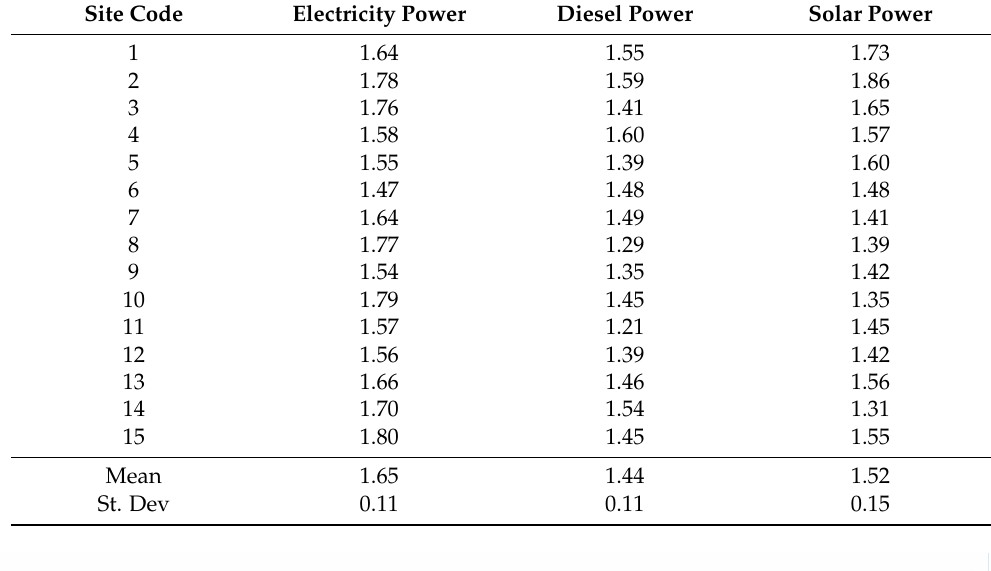
Table 1. B-C ratio of different power sources for DIS.